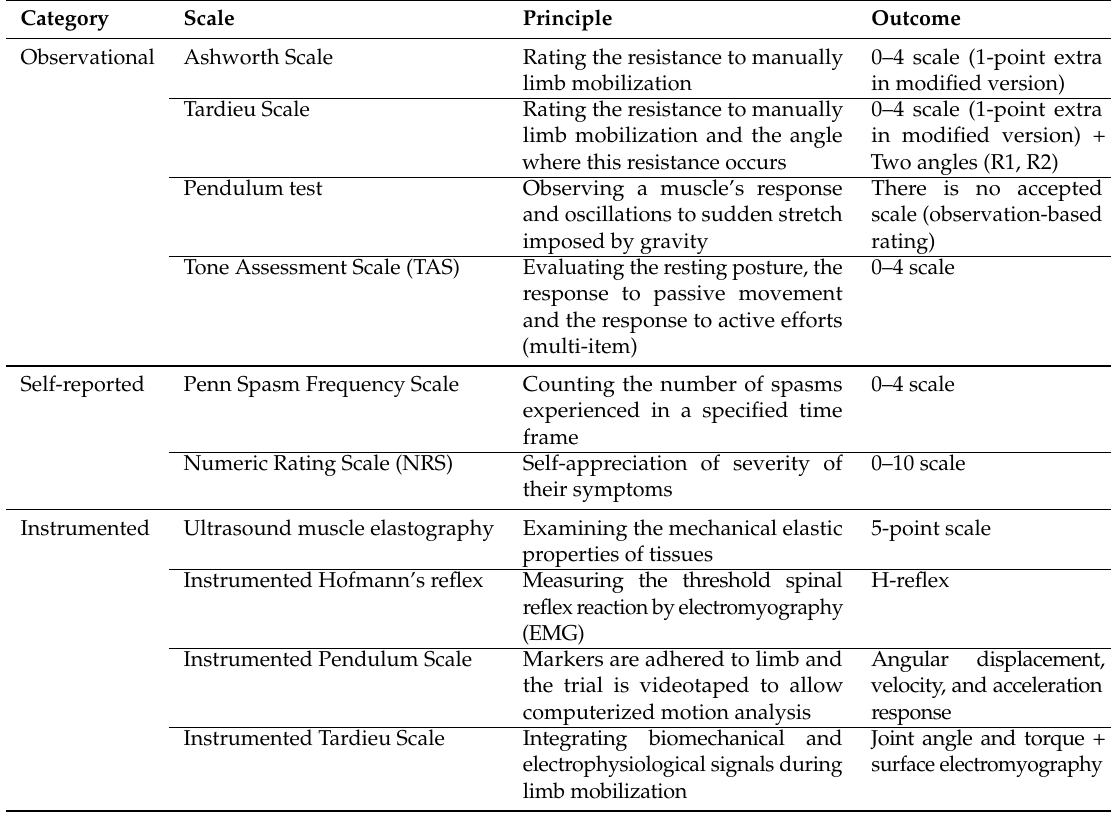
Table 1. Overview of procedures for measuring spasticity according to